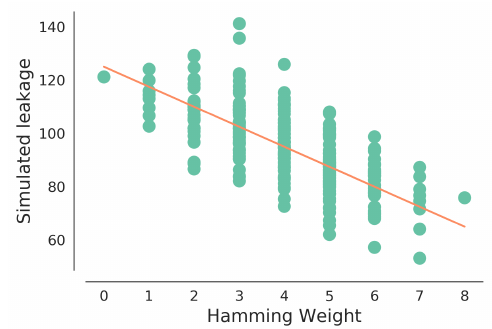
Figure 4: Simulated leakages vs. actual Hamming weights for